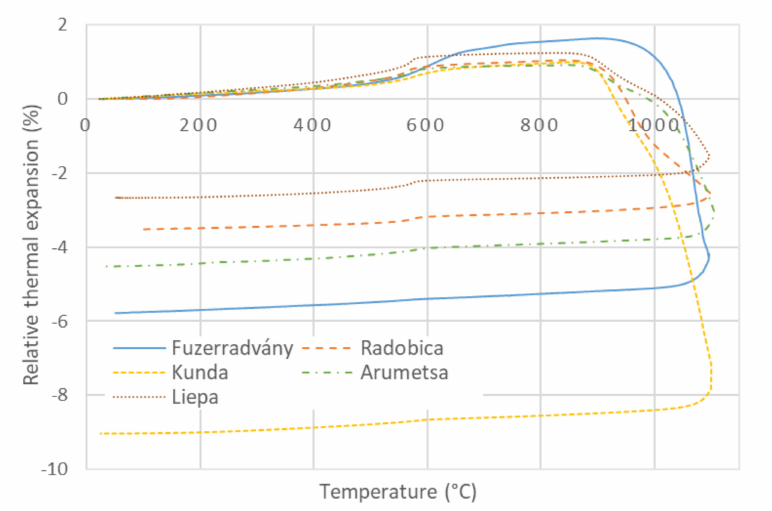
Figure 2. Relative thermal expansion of investigated